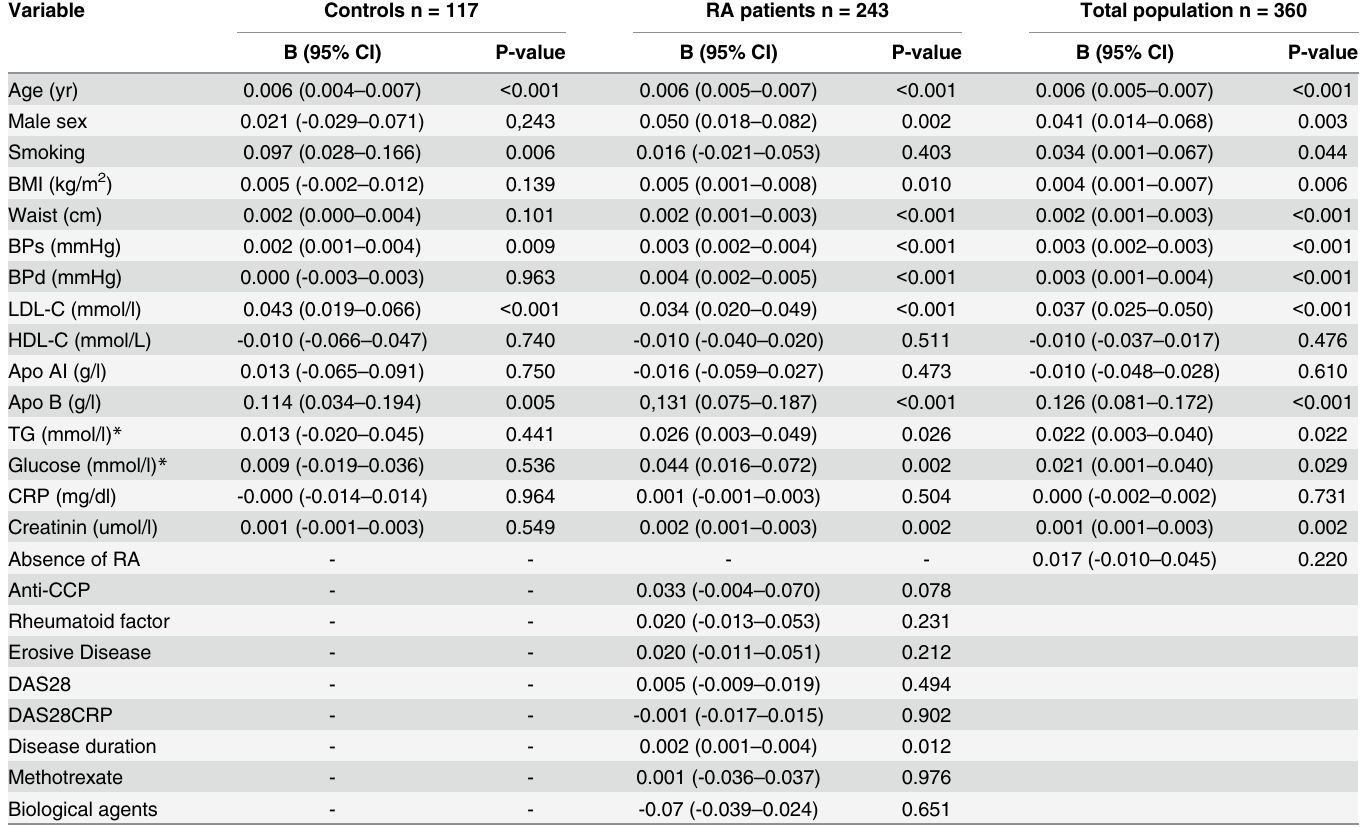
Table 2. Univariate regression analysis identifying covariables associated with